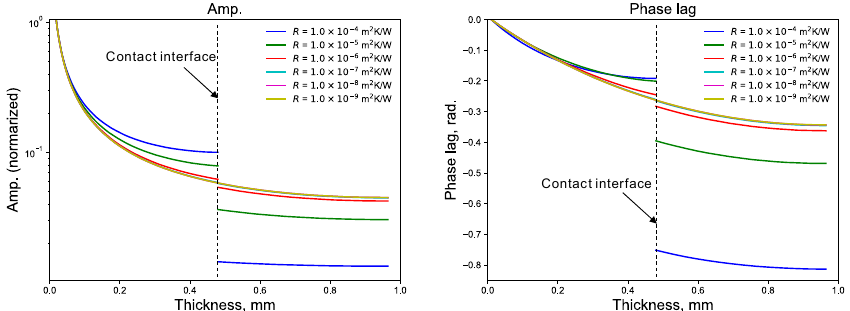
Figure 2. Theoretical curve of amplitude and phase lag for different thermal contact resistance.